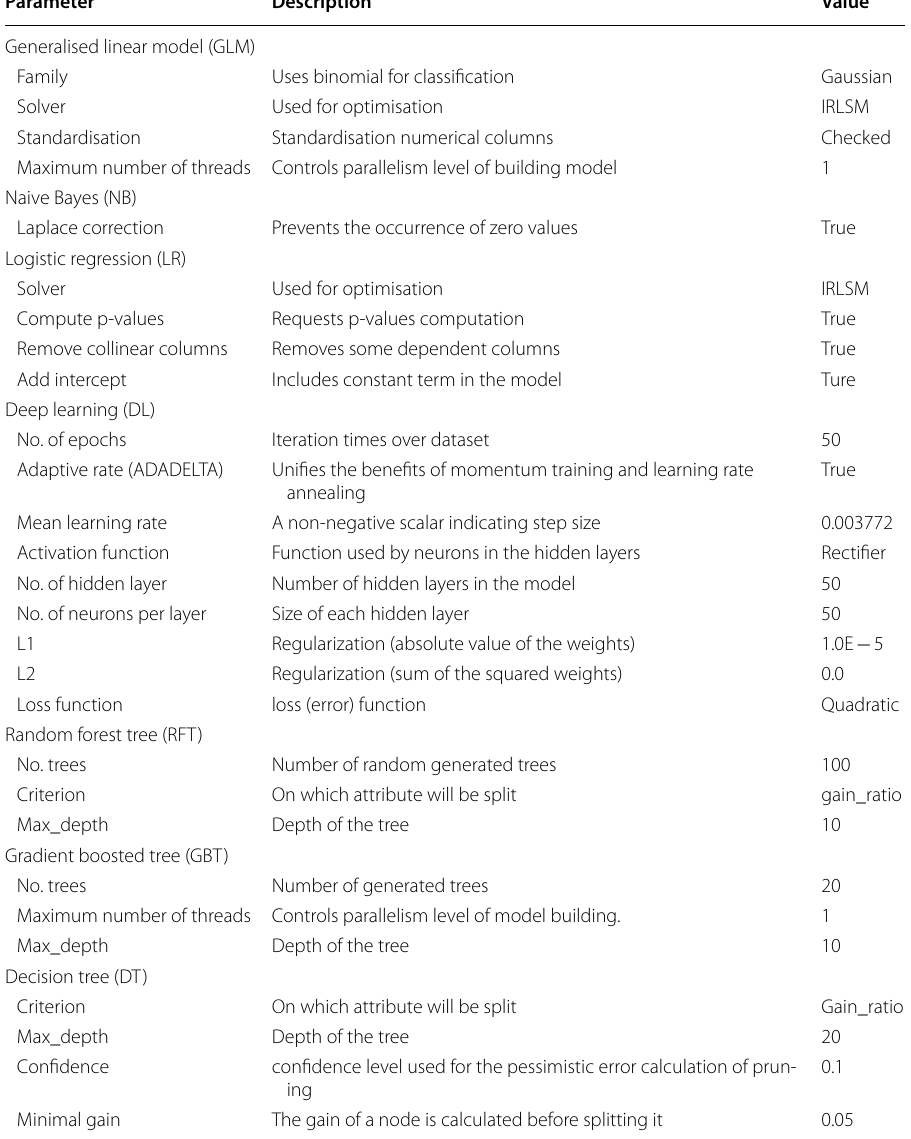
Table 8 Selected parameter settings for machine learning models Parameter